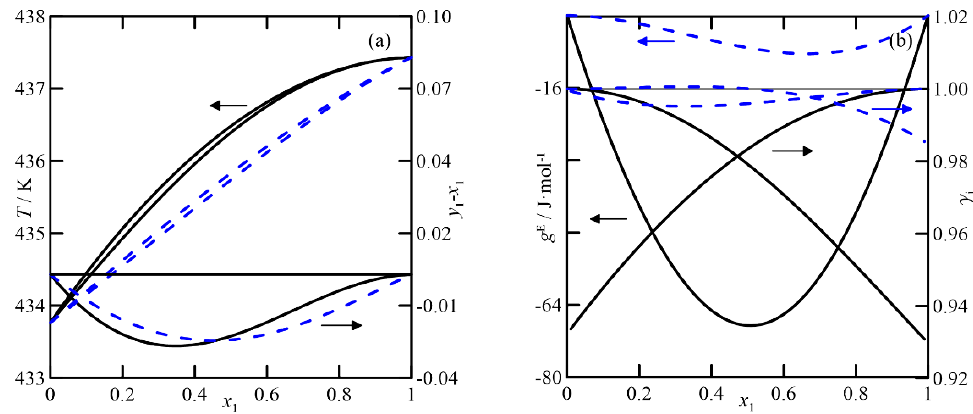
Figure 9. Estimations of VLE at 101.32 kPa of 2-methylcyclohexanone + cyclohexanol, (----) UNIFAC- DM; (- - -) COSMO-RS. ( a ) T ,x,y and (y − x ), x ( b ) γ i vs x and g E / RT vs x .